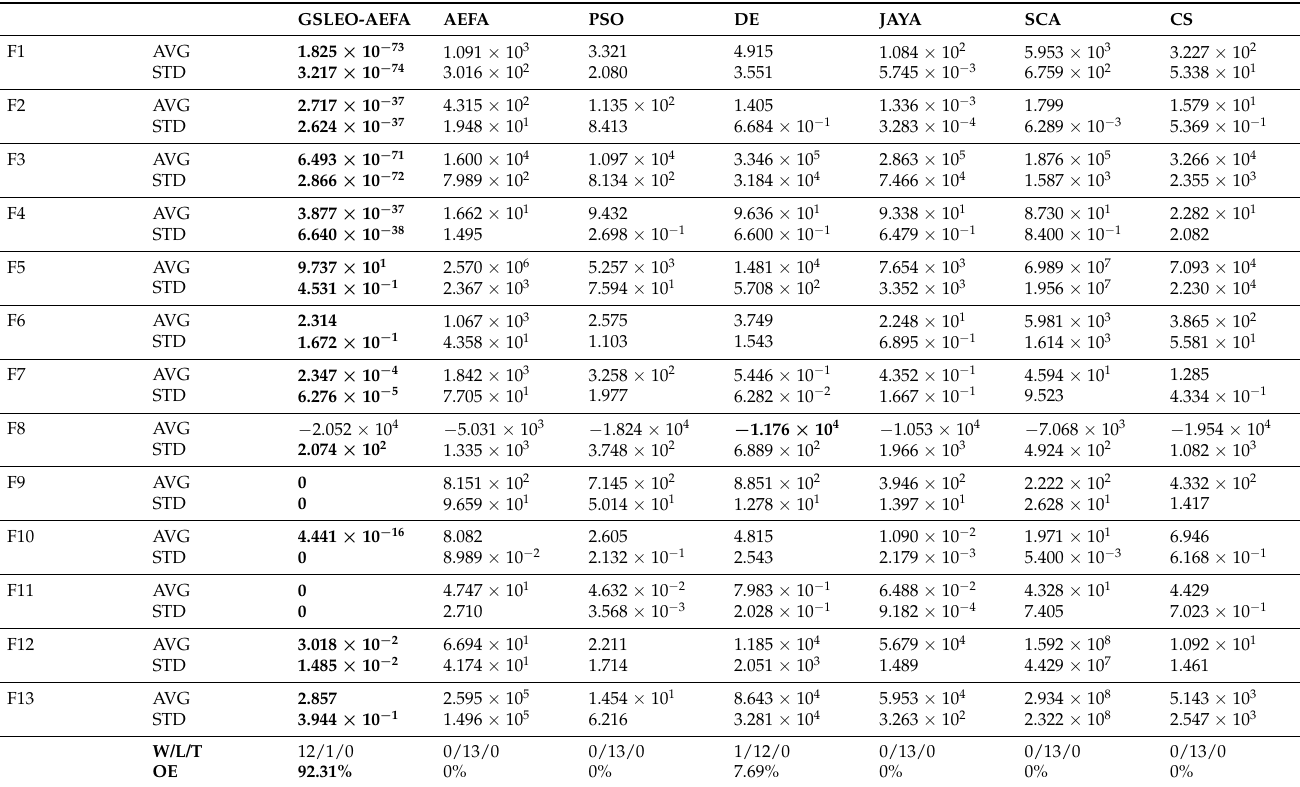
Table 5. F1–F13 Comparison with dimension = 100, significant values are in bold.